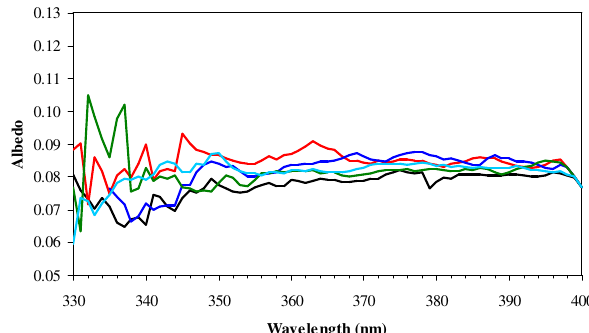
Figure 2. Spectral variability of albedo for water surface in the UV region only measured on 13 May 1984 (black line), 14 May 1984 (red line), 15 May 1984 (blue line), 16 May 1984 (green line) and 17 May 1984 (cyan